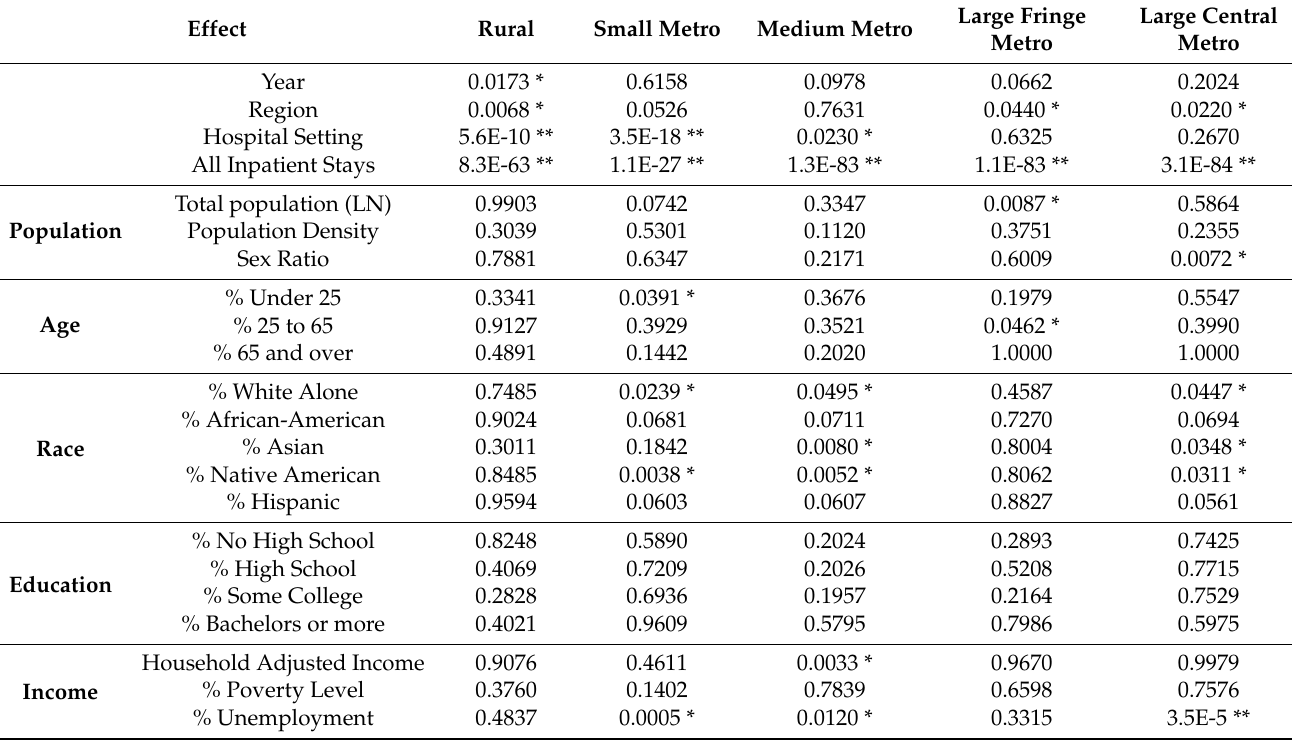
Table 2. Demographic covariate association to opioid-related hospital visits compared across different community popula- tion sizes in the entire United States. * Significant at p ≤ 0.05. ** Significant at Bonferroni adjusted p